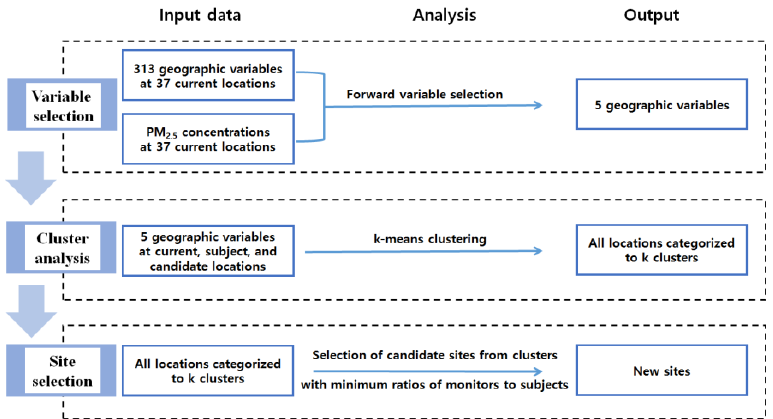
Figure 1. The procedure of selecting 20 new monitoring sites supplementary to regulatory monitoring sites in Seoul, Korea.